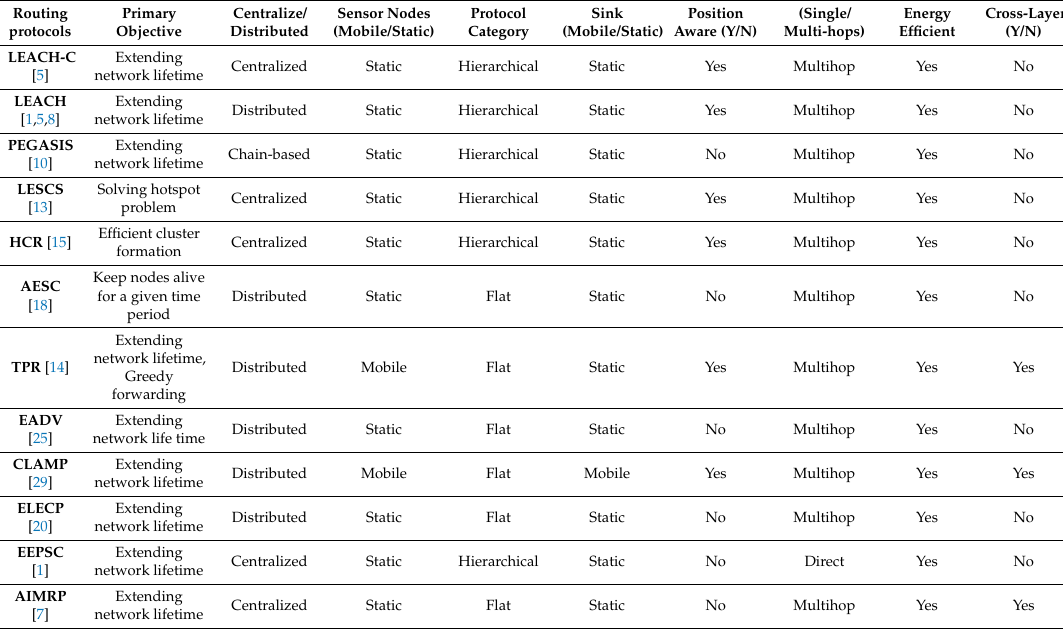
Table 1. Comparison of popular routing protocols in